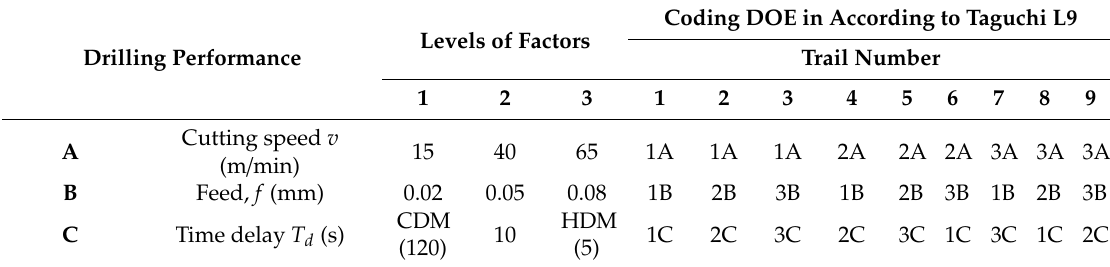
Table 4. Drilling performances and their levels and the design of the experiment according to the Taguchi orthogonal array L 9